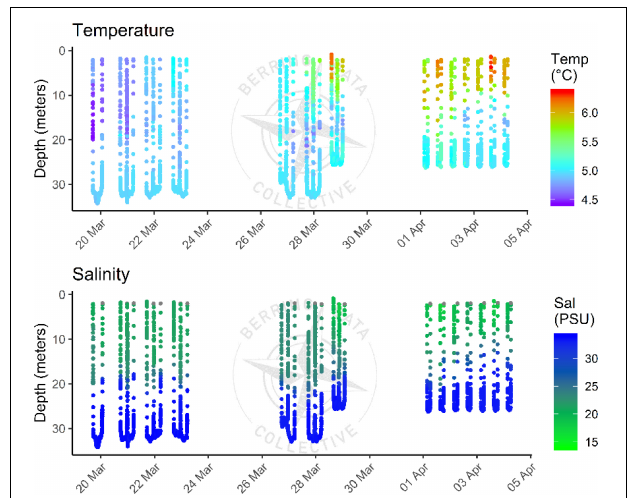
FIGURE 2 | Temperature and salinity profiles measured from a CTD sensor mounted on a bottom trawl net off of Denmark in 2019. For a comprehensive quality assessment of similar data collected via fishing vessels, see Aydo˘gdu et al.